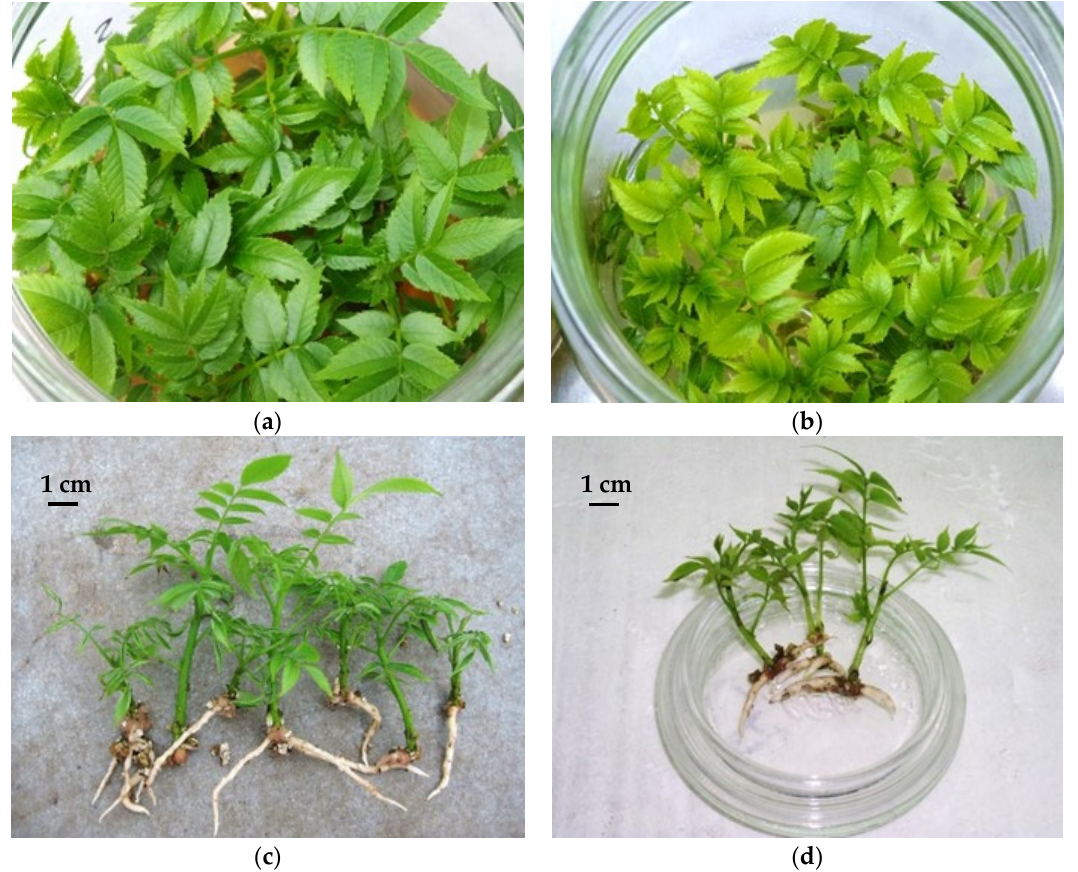
Figure 1. Effect of substituting FeEDDHA ( a , c ) for FeEDTA ( b , d ) in DKW–C medium, on chlorosis, growth and rooting of clones from the Juglans hybrid progeny Mj209 × Ra (photos provided by R.J. Licea-Moreno).